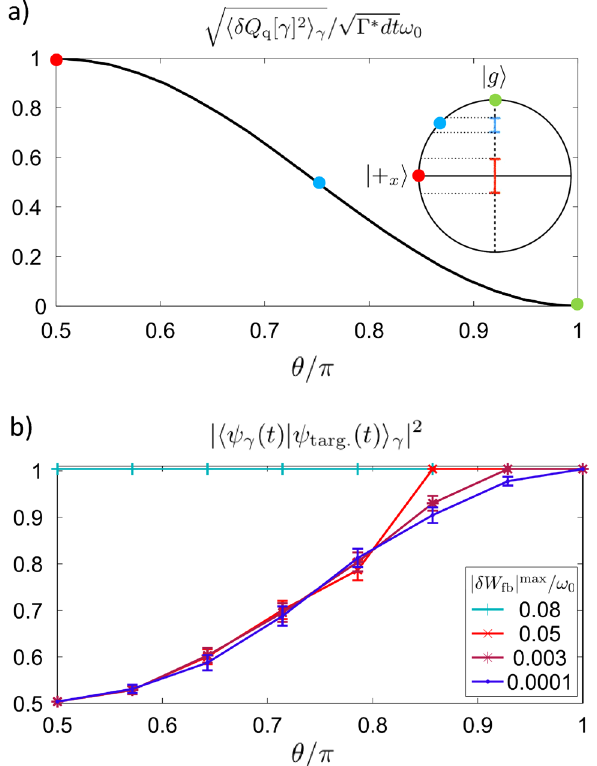
Fig. 5 Ef fi ciency of the feedback protocol depending on the state to stabilize | ψ targ. 〉 . a : Standard deviation of the quantum heat increment γ ]( t ) depending on the latitude θ on the Bloch sphere of the state δ Q q [ 〉 . b : Average fi delity of the fi nal state | ψ | ψ targ. ( t ) 〉 as a function of the latitude θ , for different values of the feed- ψ targ. ( t ) back work cutoff | δ W fb | max . The error bars stand for the 99% con fi dence interval. In all plots, we took (cid:1) h ¼ 1 . The trajectories last for t = 20/ Γ *